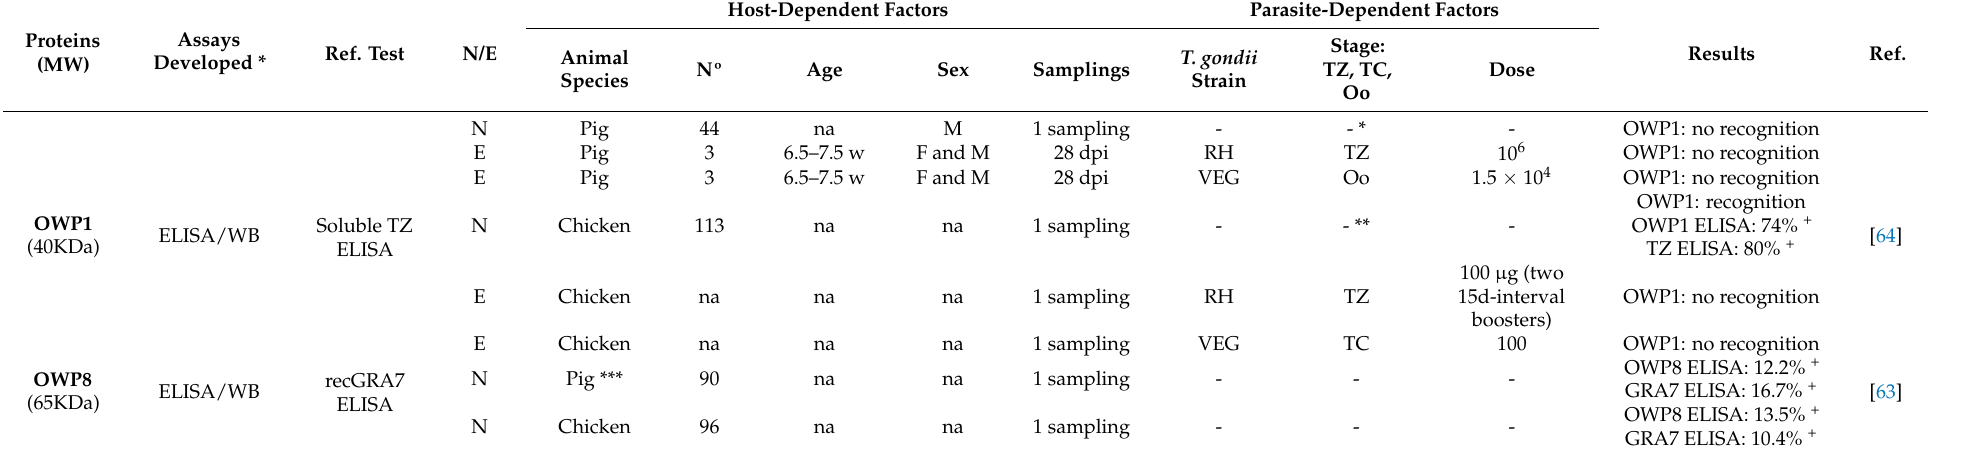
Table 1. Oocyst wall recombinant protein-based serological tests developed to differentiate oocyst-driven infections from tissue cyst-driven infections in animals.